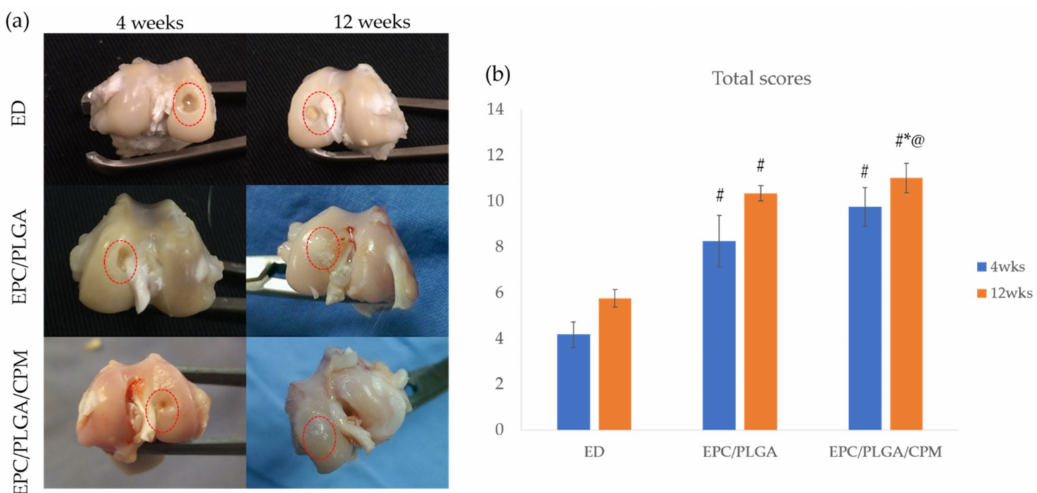
Figure 3. Macroscopic tissue regeneration in different groups. Gross appearance of the articular cartilage defects at 4 and 12 weeks post-operation, the red dotted circles indicate the defect sites ( a ). Qualitative scores of the gross appearances of the empty defect (ED), EPC/PLGA, and EPC/PLGA/CPM groups at 4 and 12 weeks post-operation ( b ). *: compared to 4 weeks post-operation, p < 0.05; #: compared to the ED at the same time point, p < 0.01; @: compared to the EPC/PLGA group at the same time point, p <